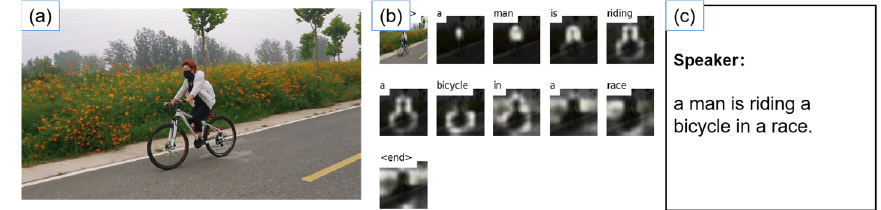
Figure 19. Image processing results of a roadside scene. ( a ) Processed images. ( b ) Processed results.